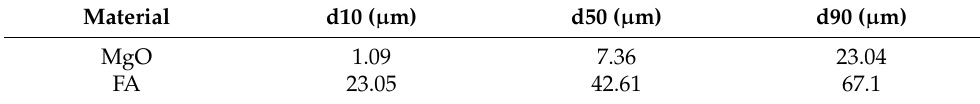
Table 2. Particle size distribution parameters obtained on a laser diffraction principle.